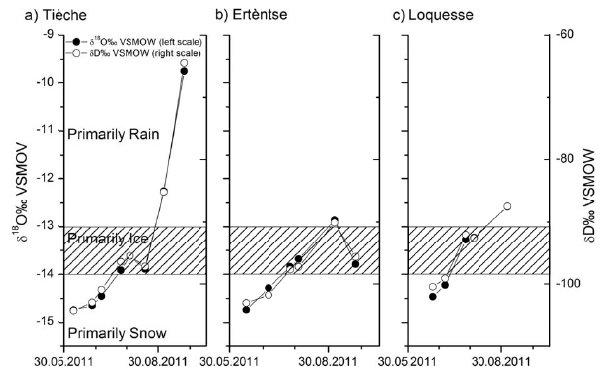
Fig. 8. Temporal development of isotopic composition at selected karst springs south of the Plaine Morte. Typical isotopic signatures Figure 8 : Temporal d development o of isotopic co omposition at t selected kar wst springs sou uth of the Pla found in ice samples are illustrated with striped area. Locations are Morte. T illustrated Typical isotop pic signatures s found in ice e samples are with striped ar rea. Location Fig. 7. Visualization of the karst system assembling all data in the Figure 7 : Visualizatio representedon of the kars st system asse embling all d modeata in the kar 3rst model. In n the upper le ft corner shown in n Figure 1. the cross s-section show w a yellow lay yer represent ting the eled layer in 3D. The base e of the Plaine e Morte shown in Fig. karst model. In the upper left corner the cross section shows a yel- glacier is s d with blue sh hading. low layer representing the modeled layer in 3-D. The base of the Plaine Morte glacier is represented with blue shading.